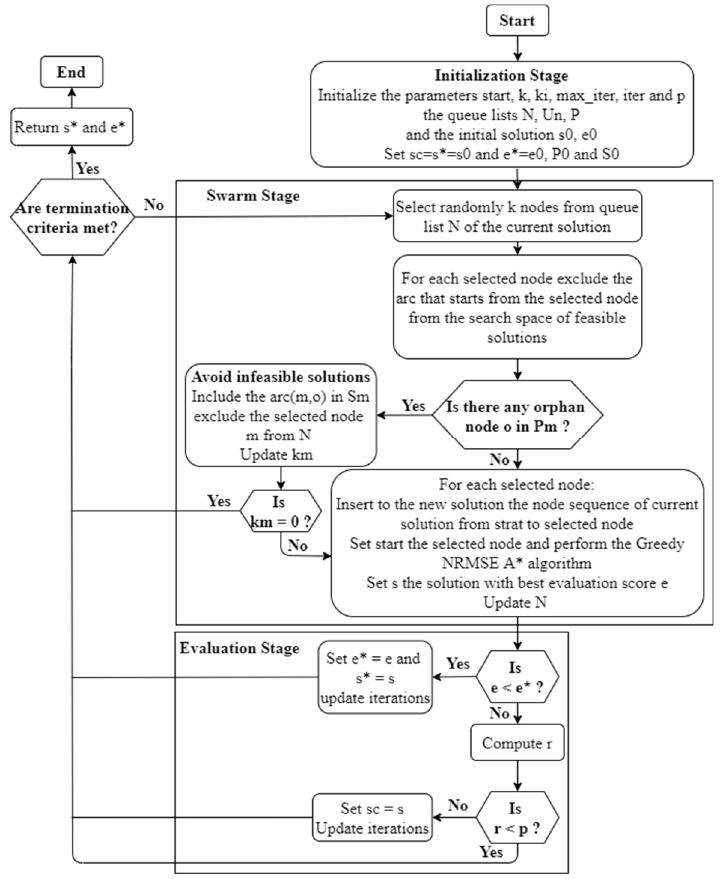
Figure 2. Flowchart of the SIGPA algorithm [11].